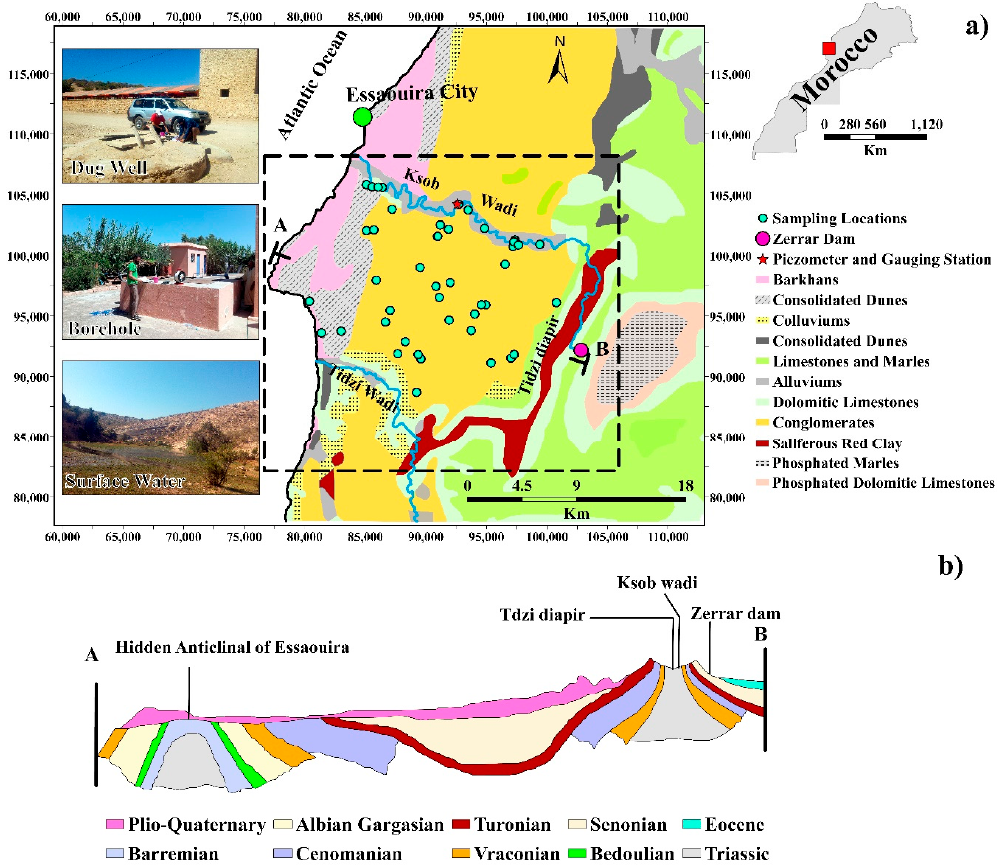
Figure 2. ( a ) Geographic location and geologic map (modified after References [12,14,15]). ( b ) Cross-section of the studied area (modified after References